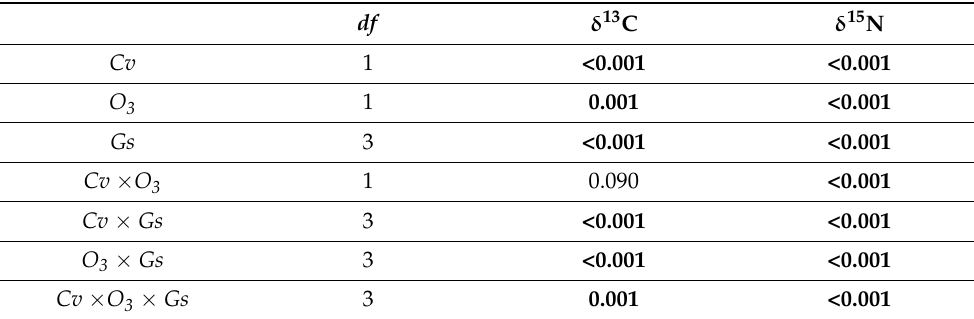
Table 4. p -values of three-way ANOVA for the effects of the cultivar ( Cv ; Claudio and Mongibello), growth stage ( Gs ; 7, 28, 50 and 70 days), ozone treatment ( O 3 ; 0 and 80 ppb, 5 h day − 1 ) and their interactions on δ 13 C and δ 15 N values of durum